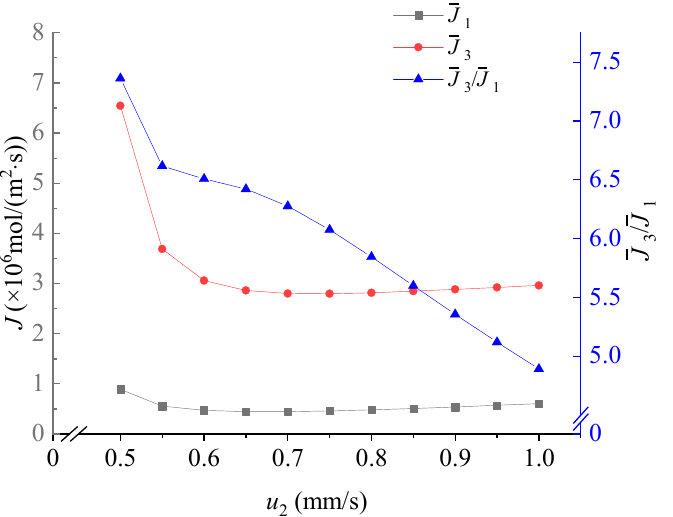
Figure 8. The dependence of the average flux of Li + , the average flux of Mg 2+ and the Mg 2+ /Li + flux ratio on u 2 . Values of other parameters are: V = 30V T , u out = 0.5 mm/s, u 1 = 0.63 mm/s, 18 μ m ≤ y ≤ 31.5 μ m , x = 96 μ m.